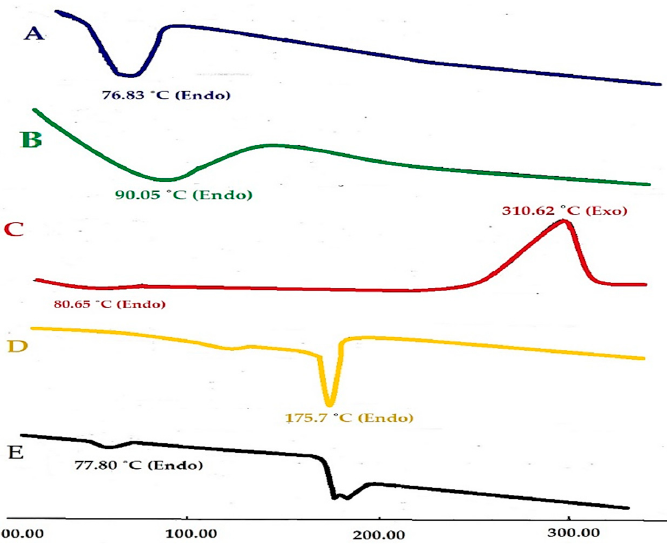
Figure 2. DSC thermograms of pure TLM ( A ); pure CP ( B ); pure CCS ( C ); pure camphor ( D ) and physical mixtures TLM/all excipients ( E ). physical mixtures TLM/all excipients ( E